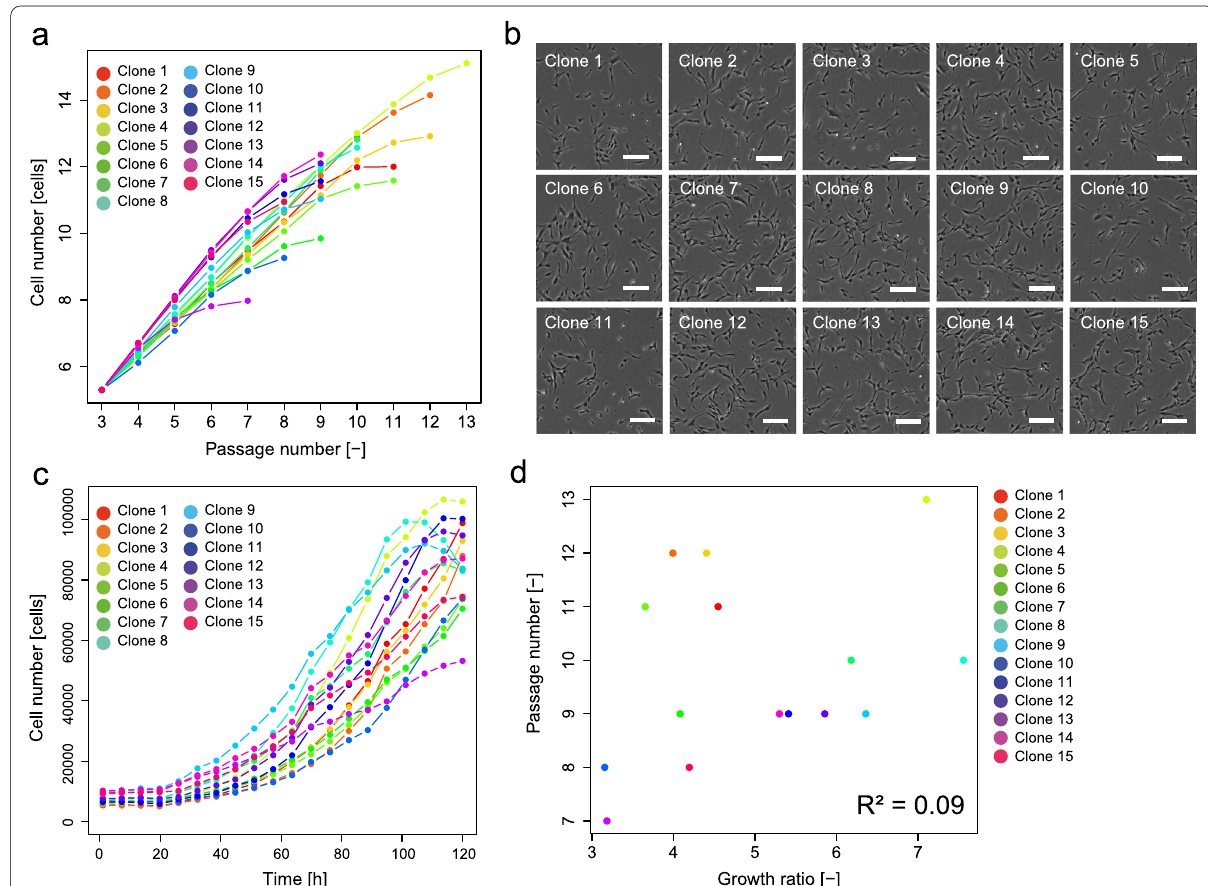
Fig. 2 Profile of 15 RECs. a Results of serial-passage tests of RECs. b Representative morphologies of RECs. c Growth profile of RECs. d Correlation of growth rate and serial-passage limitation number. R 2 indicates the coefficient of